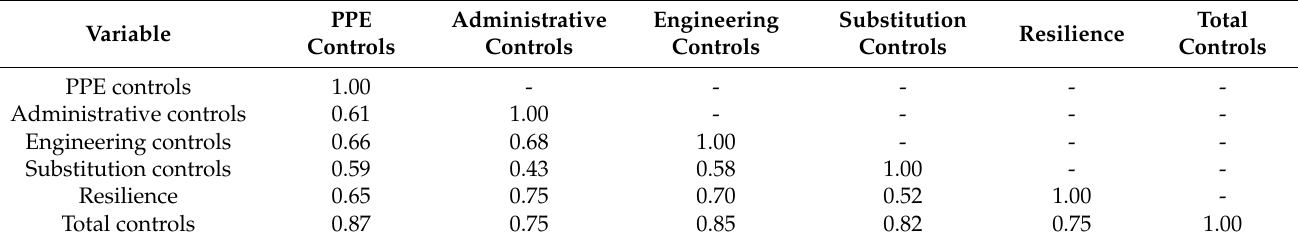
Table 8. The results of the Spearman correlation between the total use of control measures and organizational resilience.